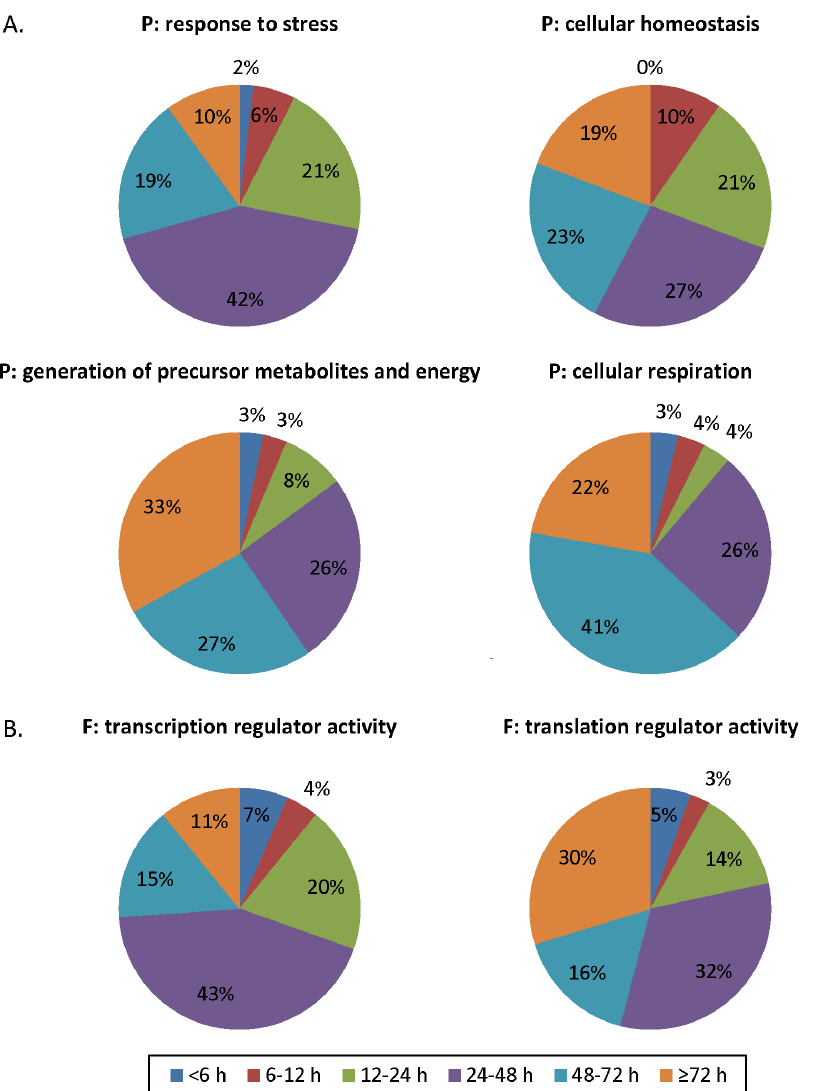
Figure 4. mRNA half-life distributions for selected GO terms. Gene ontology terms were assigned using Blast2GO Yeast GO slim. mRNA half- lives were binned on time and distributions are shown for selected GO terms. A. Biological Process GO terms. GO:0006950, response to stress; GO:0019725, cellular homeostasis; GO:0006091, generation of precursor metabolites and energy; GO:0045333, cellular respiration. B. Molecular Function GO terms. GO:0030528, transcription regulator activity; GO:0045182, translation regulator